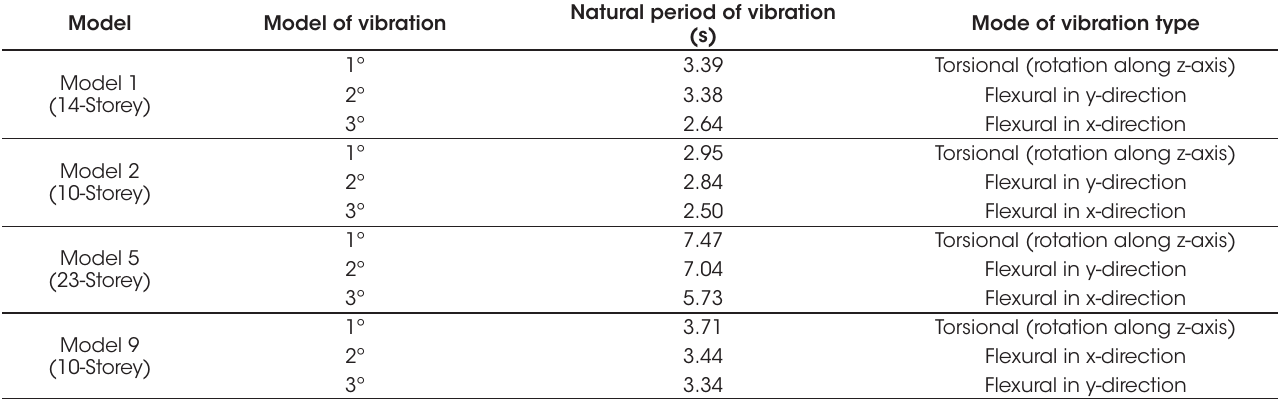
Structures modes of vibration of Models 1, 2, 5 and 9